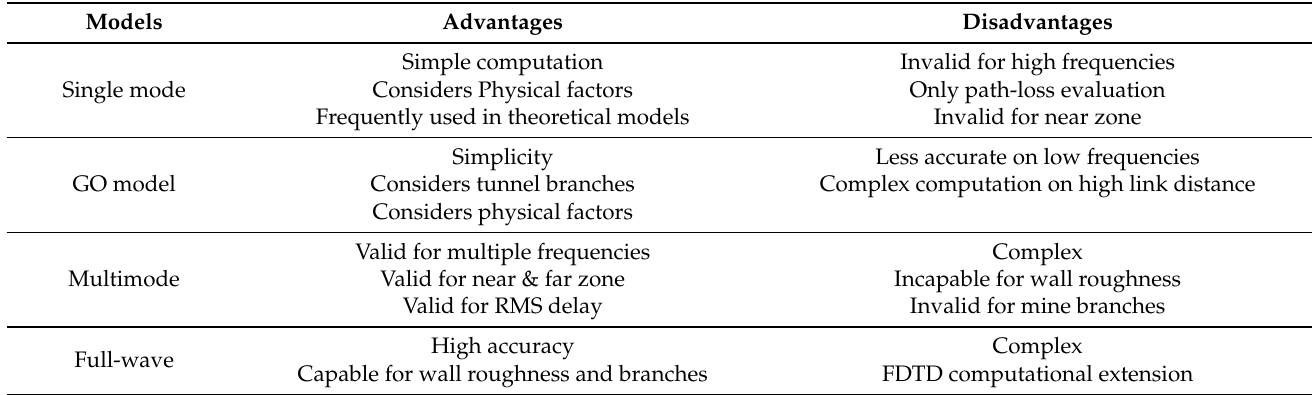
Table 1. Summary of advantages and disadvantages of existing communication channel models for underground